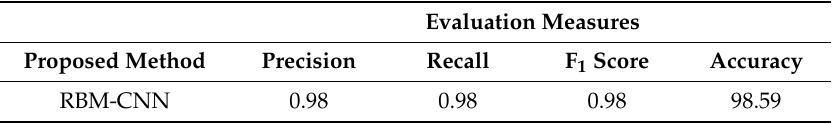
Table 4. Classification result on the CMATERDB 3.3.1 dataset using